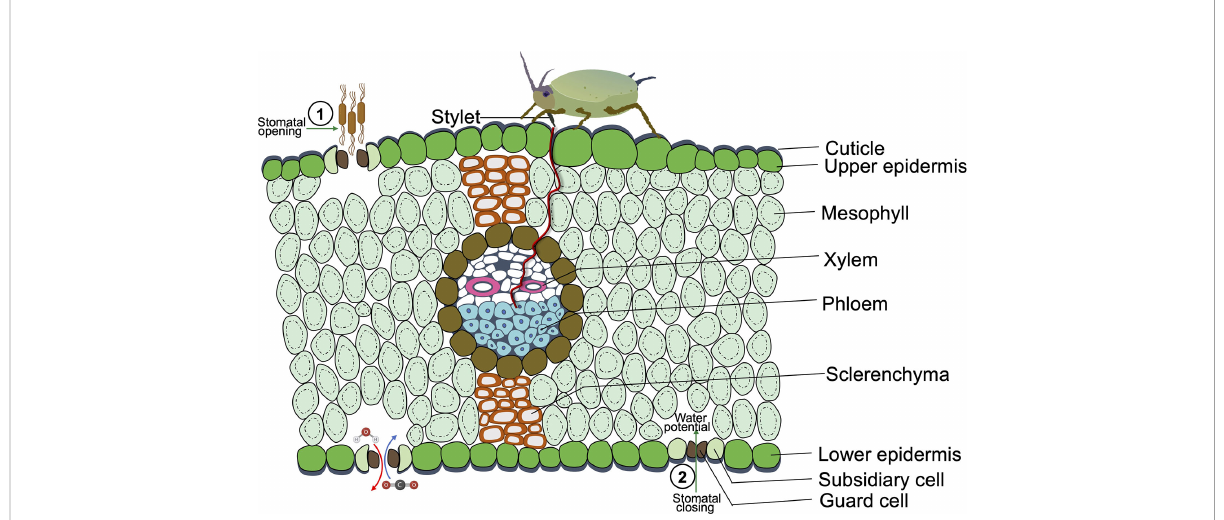
FIGURE 1 A Cross-sectional diagram of phloem sap-sucking insects feeding on a leaf of a monocot species. The opening of stomata favors pathogen invasion, as it eases the pathogen entry into plant tissues. While the sap-sucking insect infestation causes stomatal closure since sap-sucking insects feed on plant vascular tissues, mainly phloem, insects feed by penetrating their stylet in the epidermal tissue and eventually reach the sugary sap in the soft phloem tissue, which causes dehydration by water sucking and leads to the closure of guard cells. The herbivory of pest and pathogen infestation induces stomatal closure or opening, which potentially leads to the competitive relationship between pests and